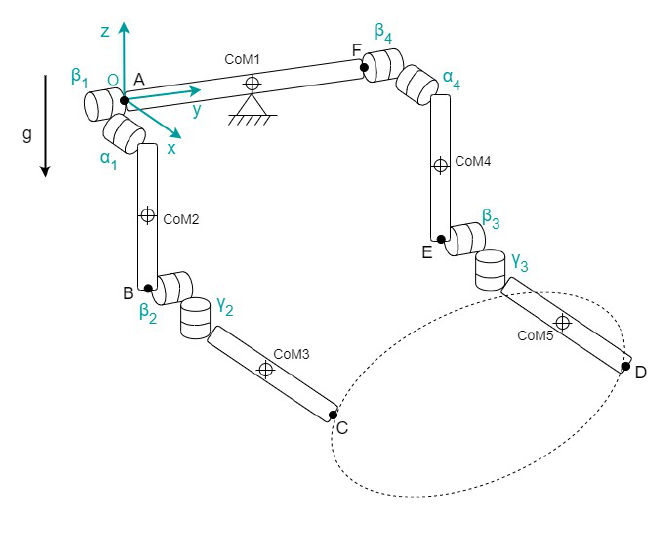
Figure 3. Illustrative diagram of the human